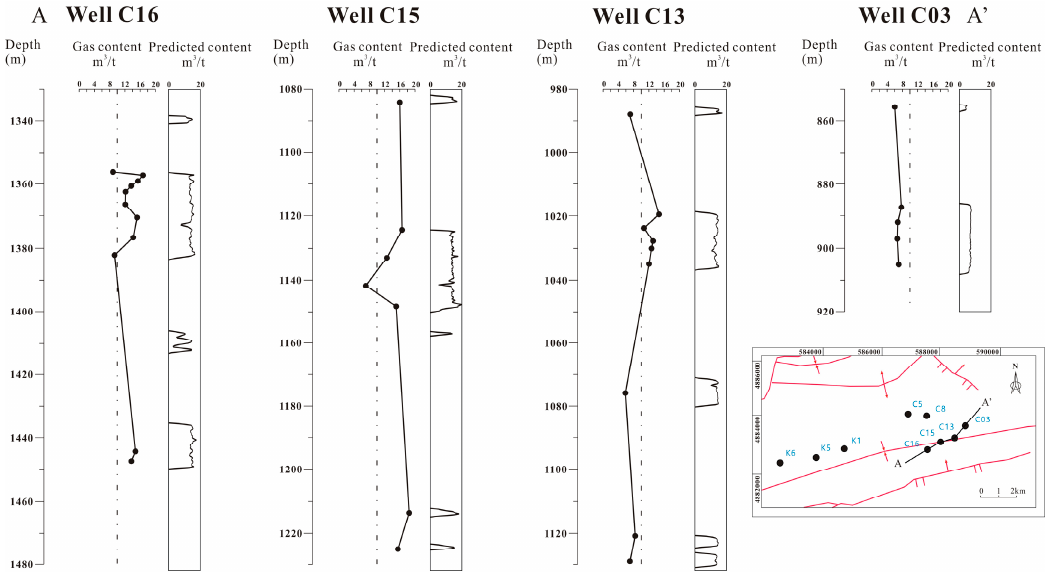
Figure 6 Figure 6. Comparison between predicted and measured gas contents on profile by the logging method with two